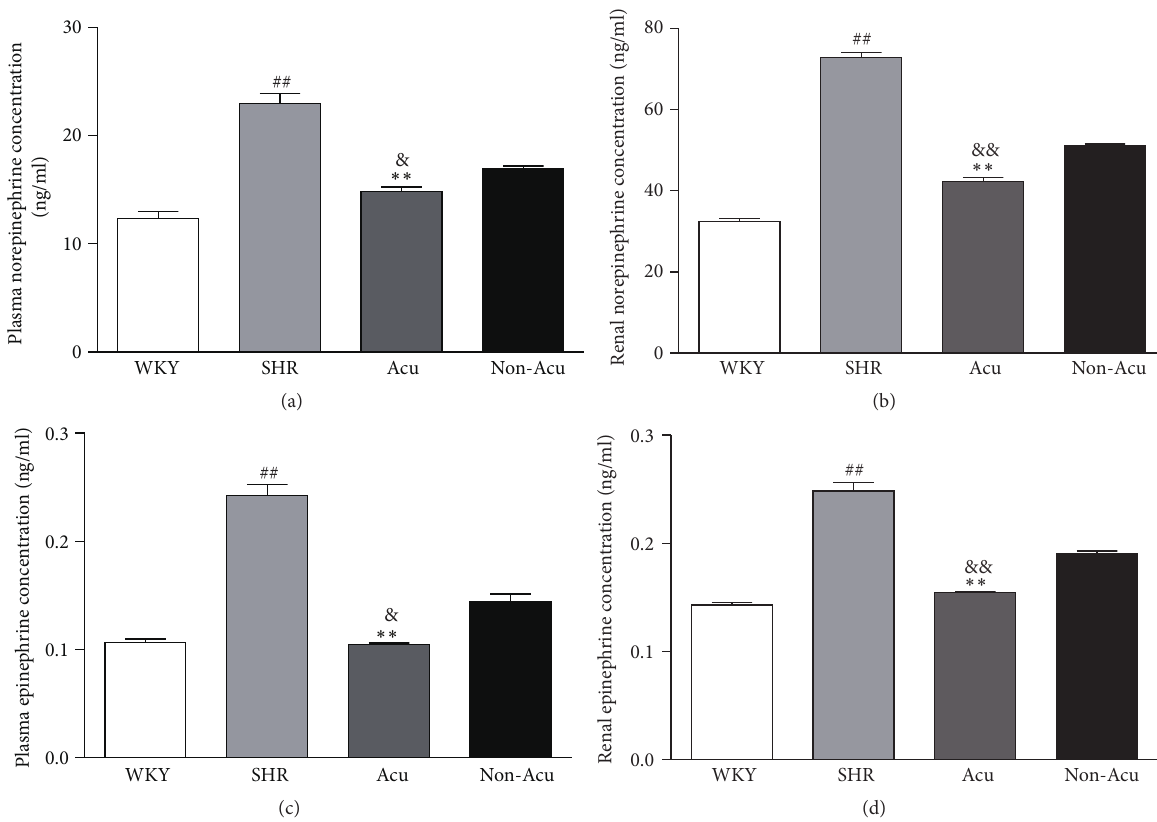
Figure 2: Effects of acupuncture on the contents of norepinephrine (a and b) and epinephrine (c and d) in plasma and renal tissues as measured by ELISA in all groups. Data are presented as mean ± SEM ( 𝑛 = 10 rats). ## indicate 𝑃 < 0.01 , compared with the WKY group; ∗∗ indicate 𝑃 < 0.01 , compared with SHR group; & and && indicate 𝑃 < 0.05 and 𝑃 < 0.01 , respectively, compared with Non-Acu